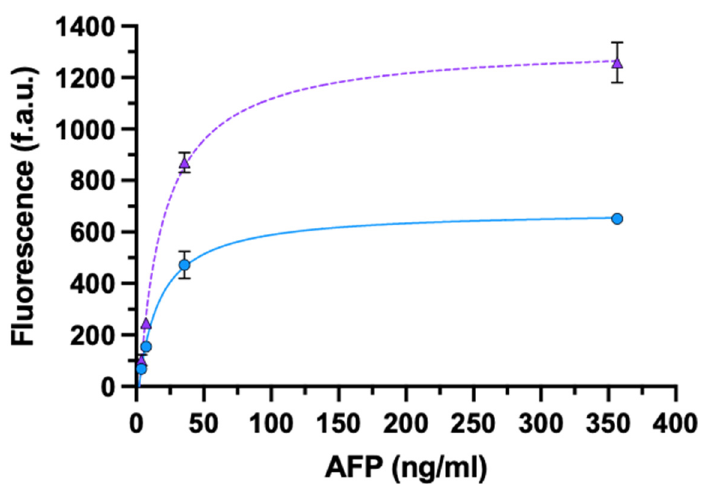
Figure 5. ELISA for the detection of AFP using oriented monovalent rIgG (circle) or non-oriented bivalent IgG (triangle). Data are presented as mean ± SD ( n = 4). Fitting equations: rIgG (solid line) y = ( − 98.43 + 49.05x)/(1 + 0.07x); IgG (dashed line) y = ( − 187.6 + 81.51x)/(1 + 0.06x).